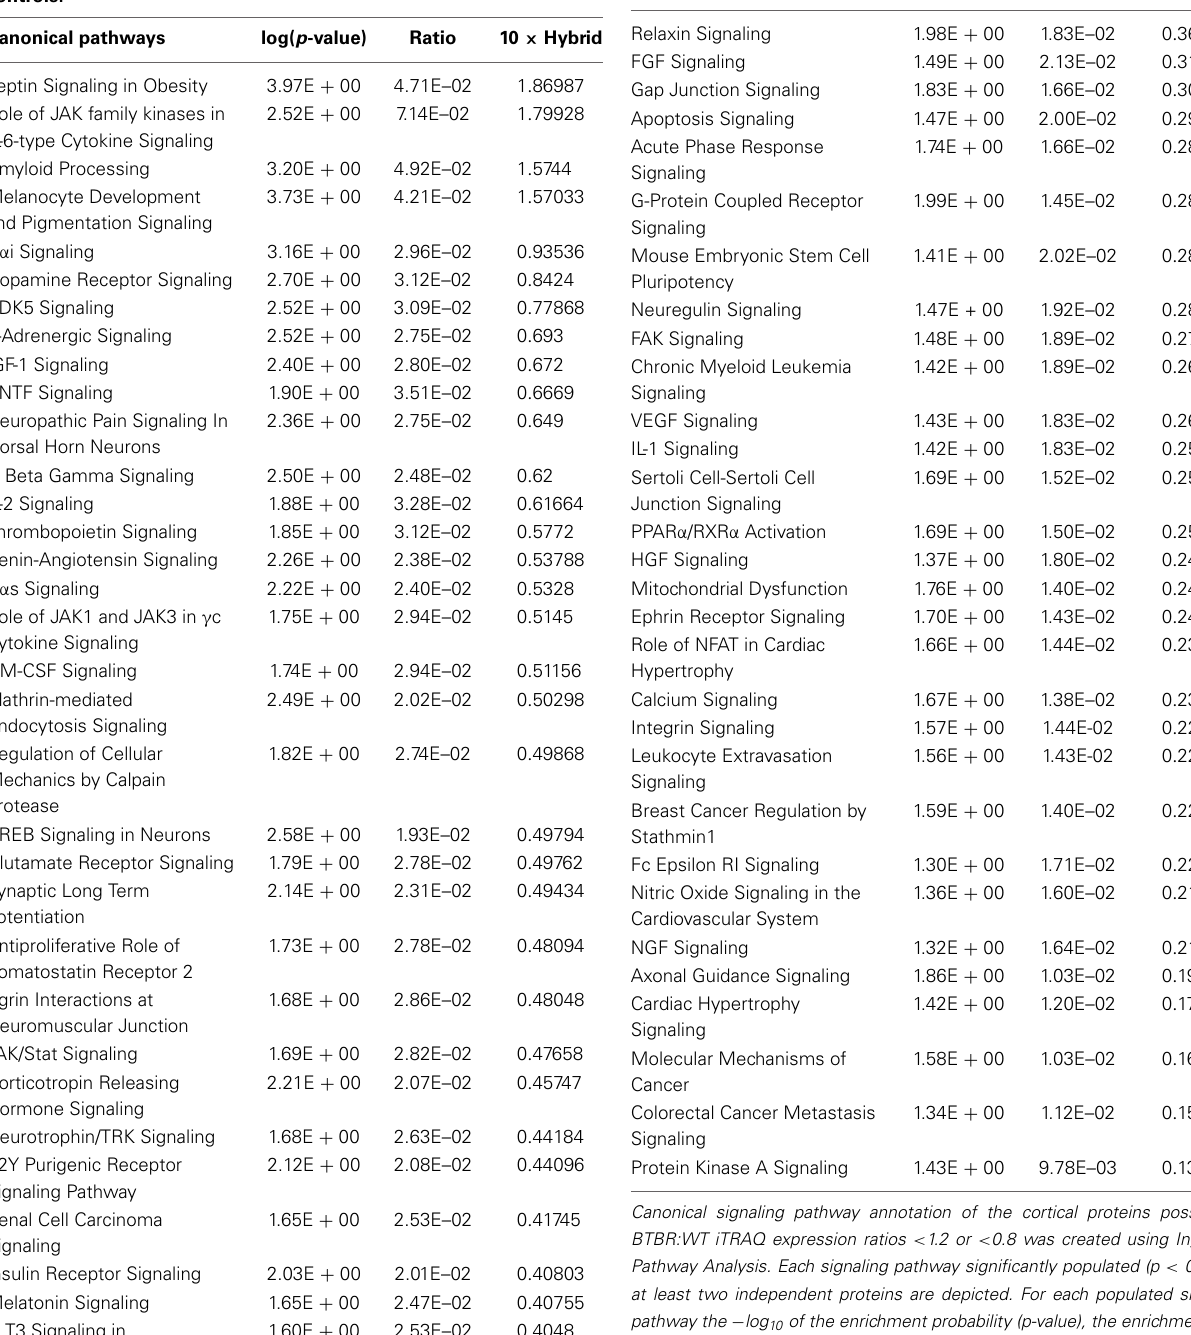
Table 5 | Ingenuity Canonical Signaling Pathway analysis of proteins differentially regulated in the cortex of aged BTBR compared to WT